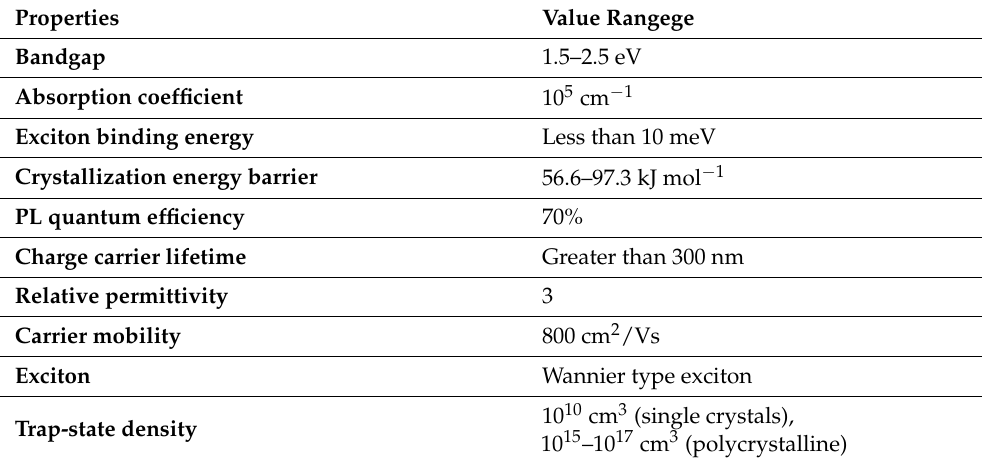
Table 1. Summarising the optical and electronic properties of perovskite materials. Reprinted with permission from Roy et al.